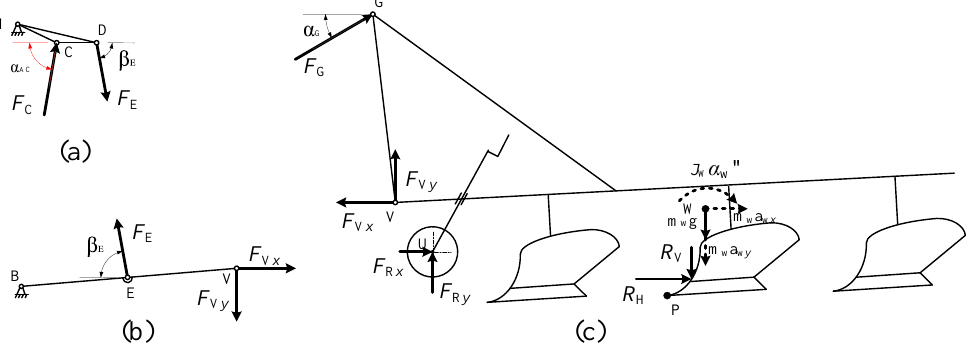
Figure 3. Simplified force analysis for tractor electronic hydraulic hitch:( a ) force analysis of lifting arm; ( b ) force analysis of lower pull rod; ( c ) force analysis of plough gear.